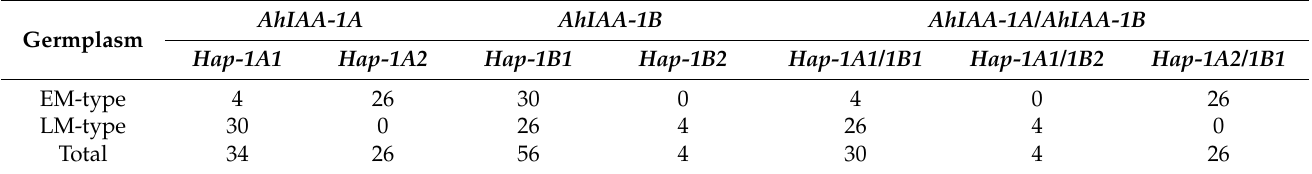
Figure 6. ( a ) Haplotypes of AhIAA-1A . Three SNP loci were located within 3 (cid:48) UTR, and their position were 105652036, 105652348 and 105652355 on chromosome Arahy.01. ( b ) Haplotypes of AhIAA-1B . One SNP were located within the third exon, and its position was 134312083 on chromosome Arahy.11. Green boxes indicated 5 (cid:48) and 3 (cid:48) UTR, yellow boxes indicated exons, and grey lines indicated introns in gene structure. Table 2. The number of EM- and LM-type germplasms among each haplotype and haplotype combination of AhIAA-1A and AhIAA-1B